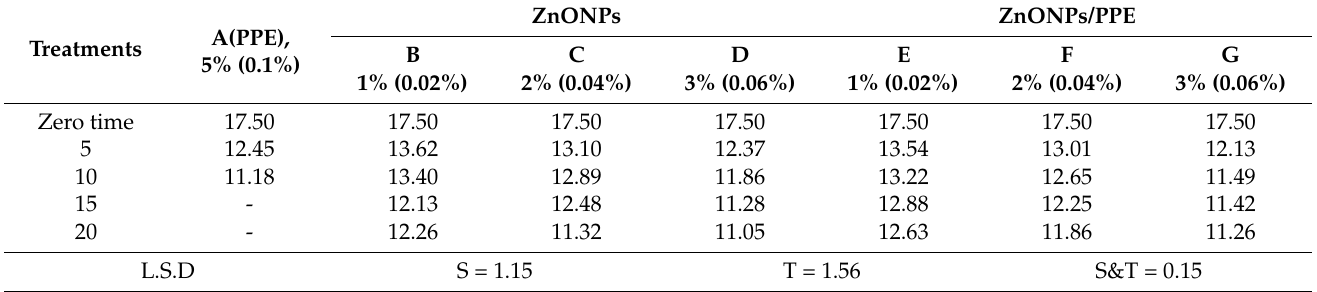
Table 9. Effect of edible film and coatings on ascorbic acid of manfalouty pomegranate during storage at 2 ◦ C.